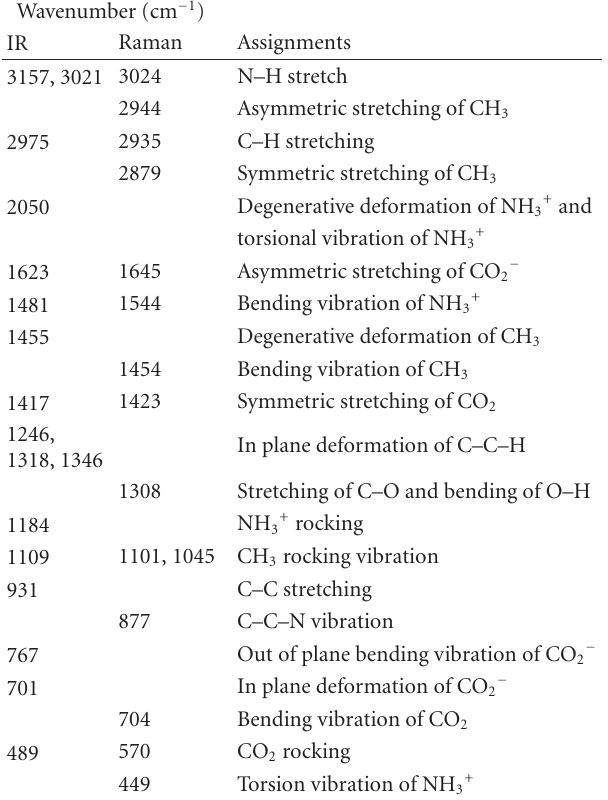
Table 3: Bands assignments of IR and Raman spectra of L-